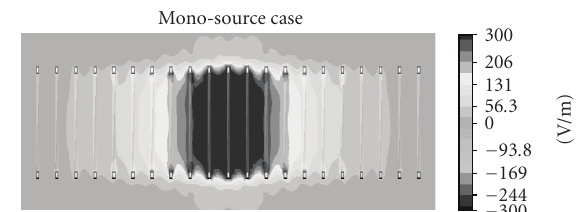
Figure 11: Distribution of the tangential electric field module | Ex | .